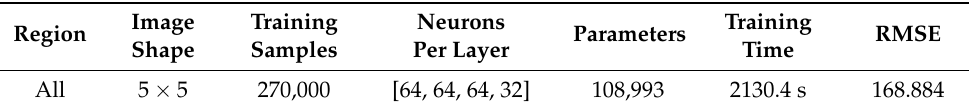
Table 3. Parameter summary of the cluster and overlap neural network.